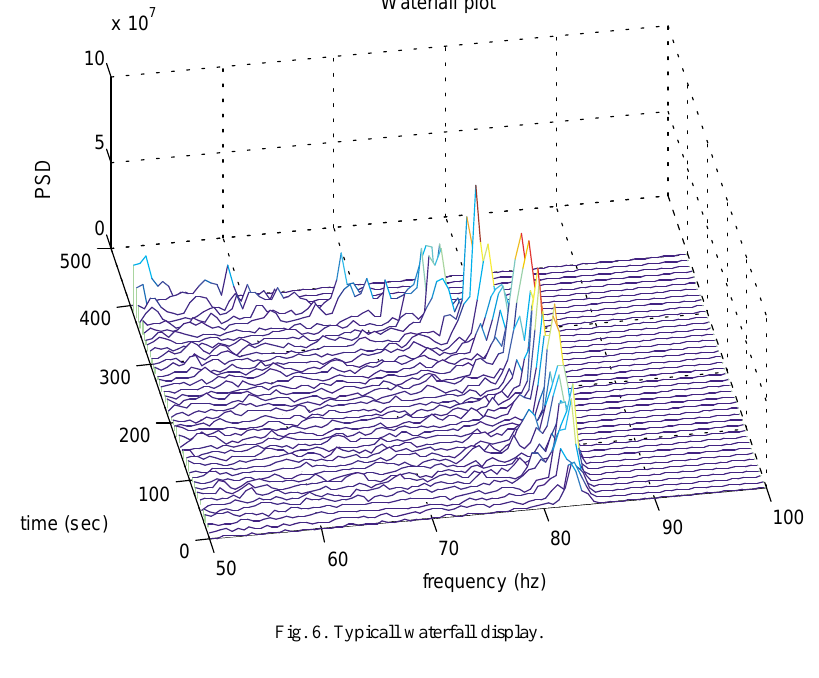
Fig. 6. Typicall waterfall display.